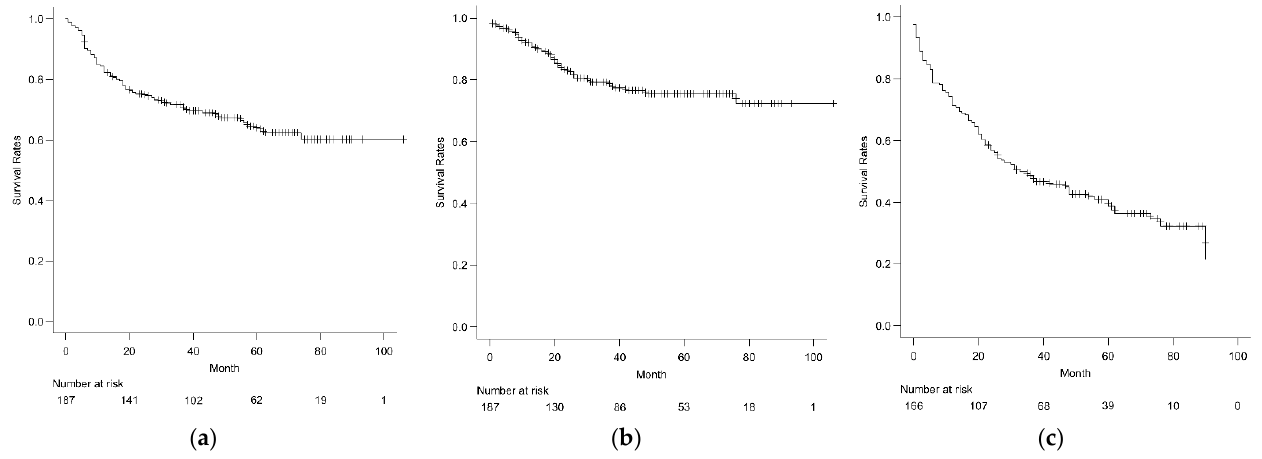
Figure 1. ( a ) Overall survival in 187 patients with pelvic and retroperitoneal bone and soft tissue sarcoma; ( b ) local-control rates in 187 patients with pelvic and retroperitoneal bone and soft tissue sarcoma; ( c ) progression-free survival in 166 M0 patients with pelvic and retroperitoneal bone and soft tissue sarcoma.